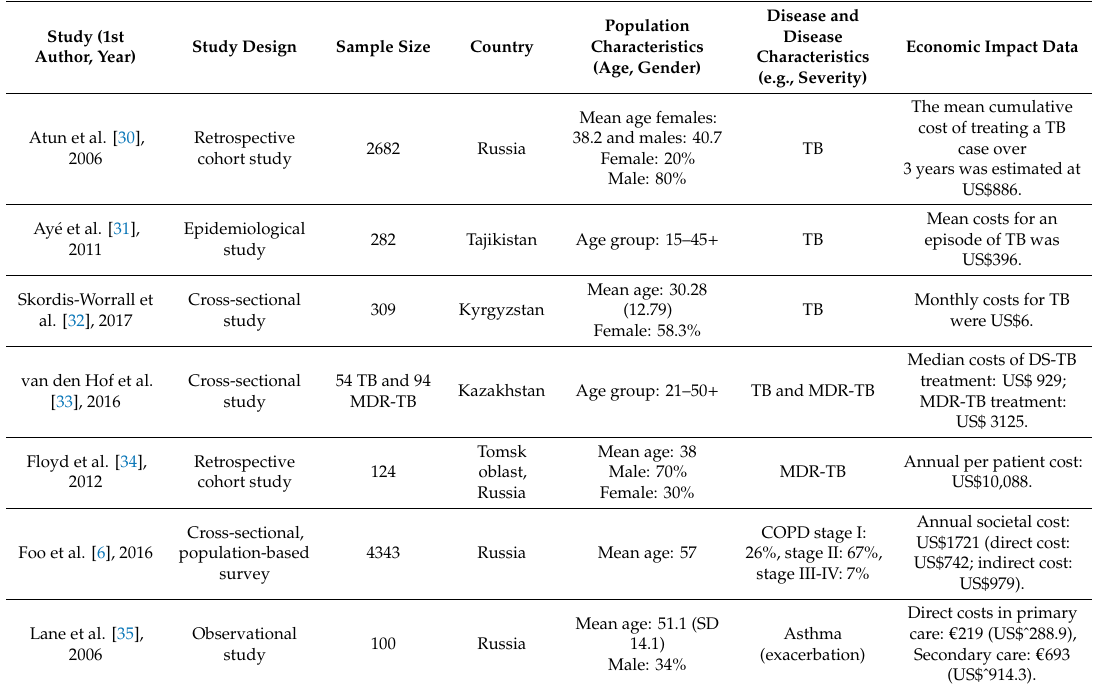
Table 2. Studies providing cost data of respiratory disease in Central Asia and Russia ( n =